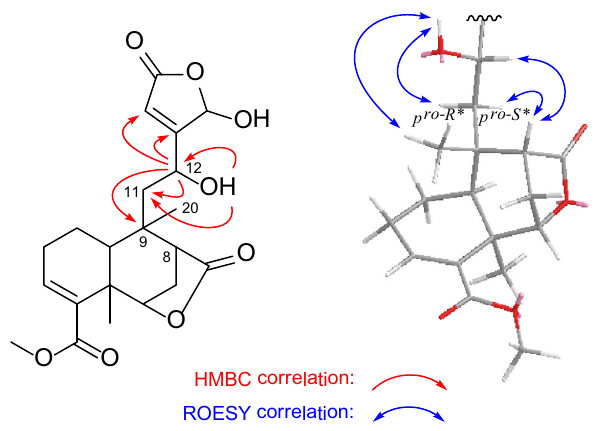
Fig. 2 Key HMBC and ROESY correlations of